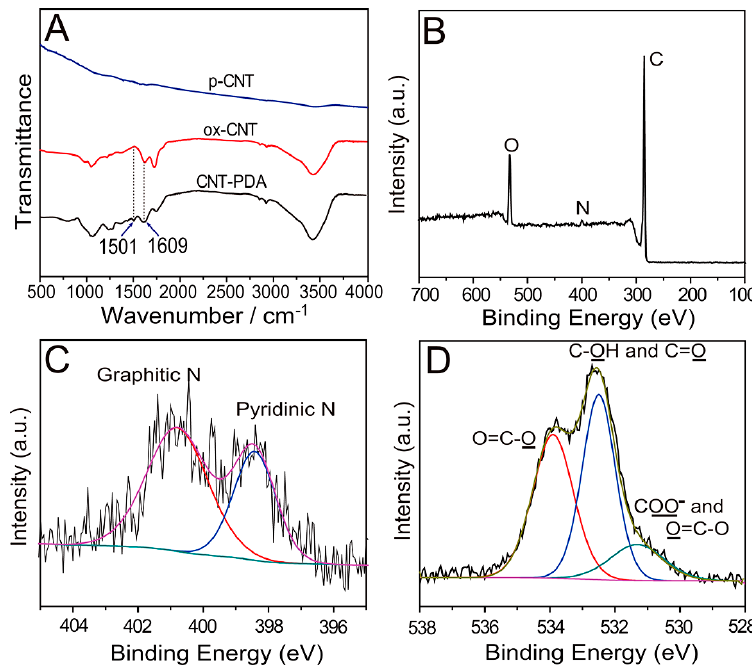
Figure 2. ( A ) FTIR spectra of p-CNT, ox-CNT and CNT-PDA. ( B – D ) XPS survey scan and the deconvoluted high-resolution spectra of N 1s and O 1s in N, O-CNT.